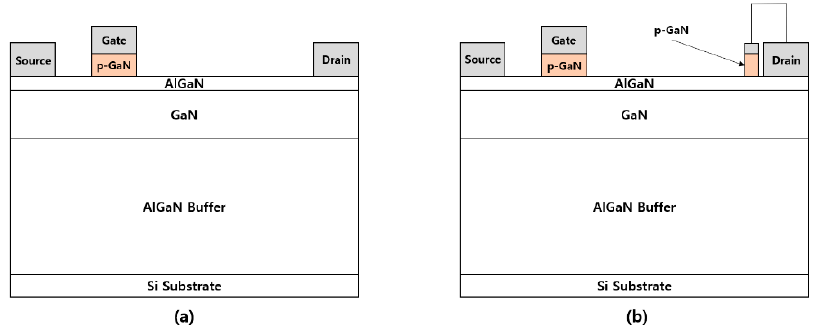
Figure 1. Cross-sectional schematics of ( a ) p-GaN gate AlGaN/GaN heterojunction field-effect transistor (HFET) and ( b ) unidirectional HFET.